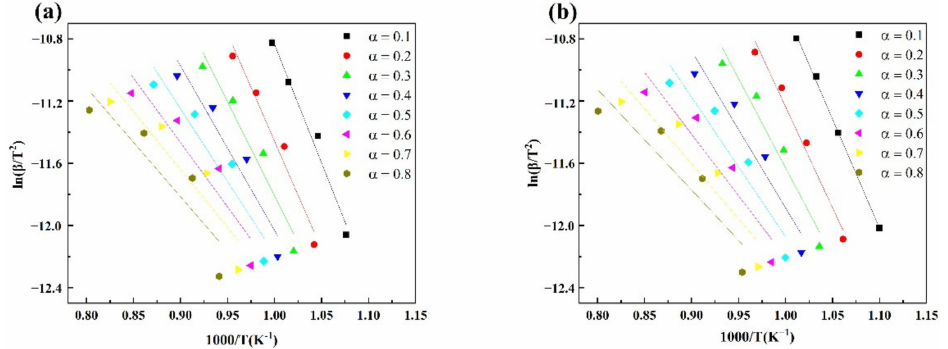
Figure 6. Fitting curves of ln( β /T 2 ) vs. 1/T of coke based on the Vyazovkin method ( a ) L-Coke, ( b )